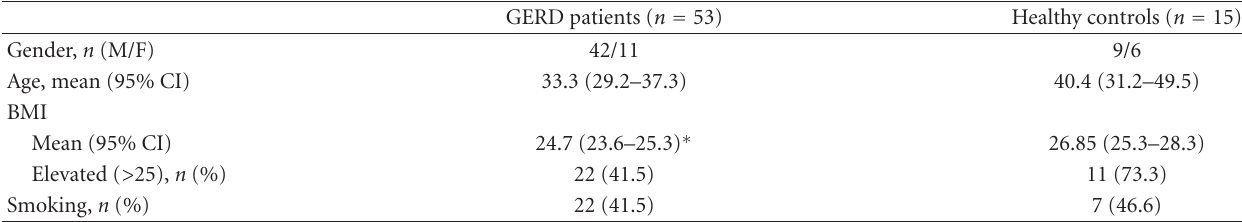
Table 1: Demographic and clinical data in GERD patients and healthy controls.